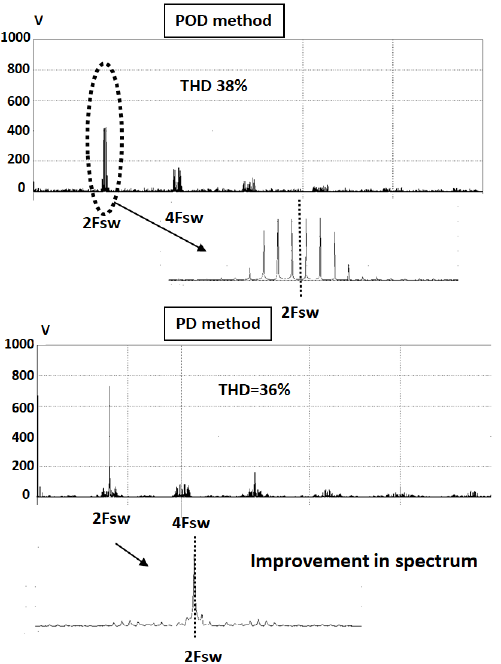
Figure 6. FFT analysis of the input voltage in the case of applied POD and PD